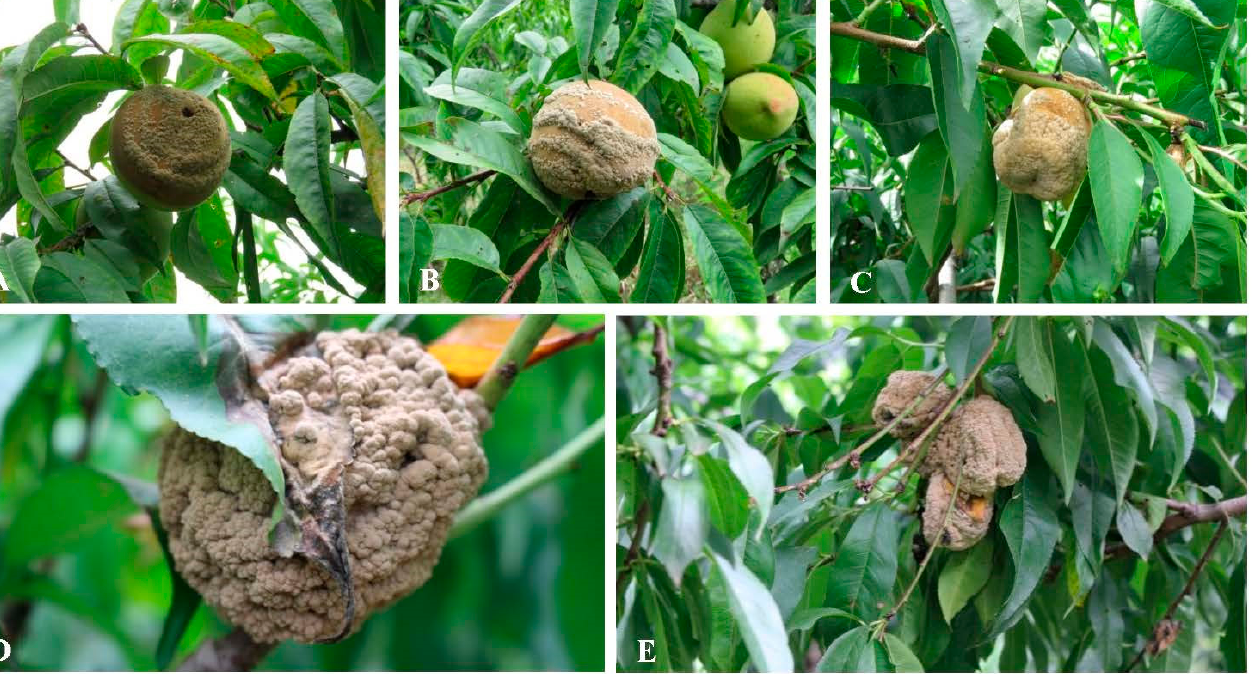
Figure 1. Symptoms of peach brown rot caused by Monilia yunnanensis in the field in Tibet, China: ( A – C ) during the growing season; ( D , E ) at harvest time.